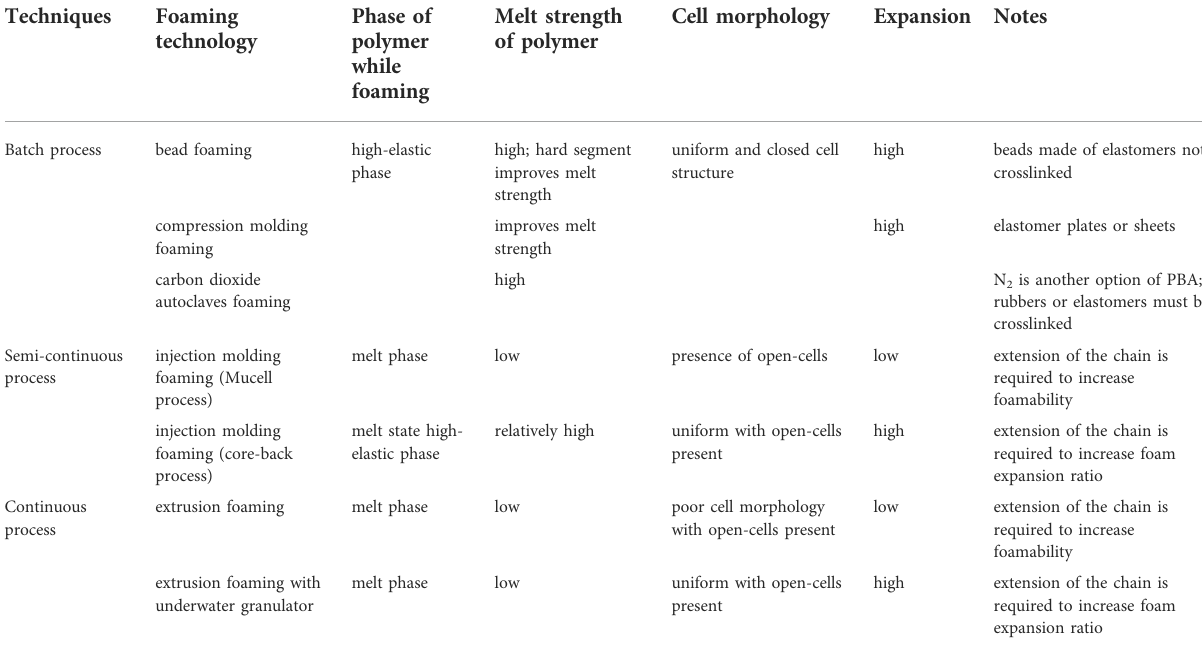
TABLE 2 The properties of different foaming